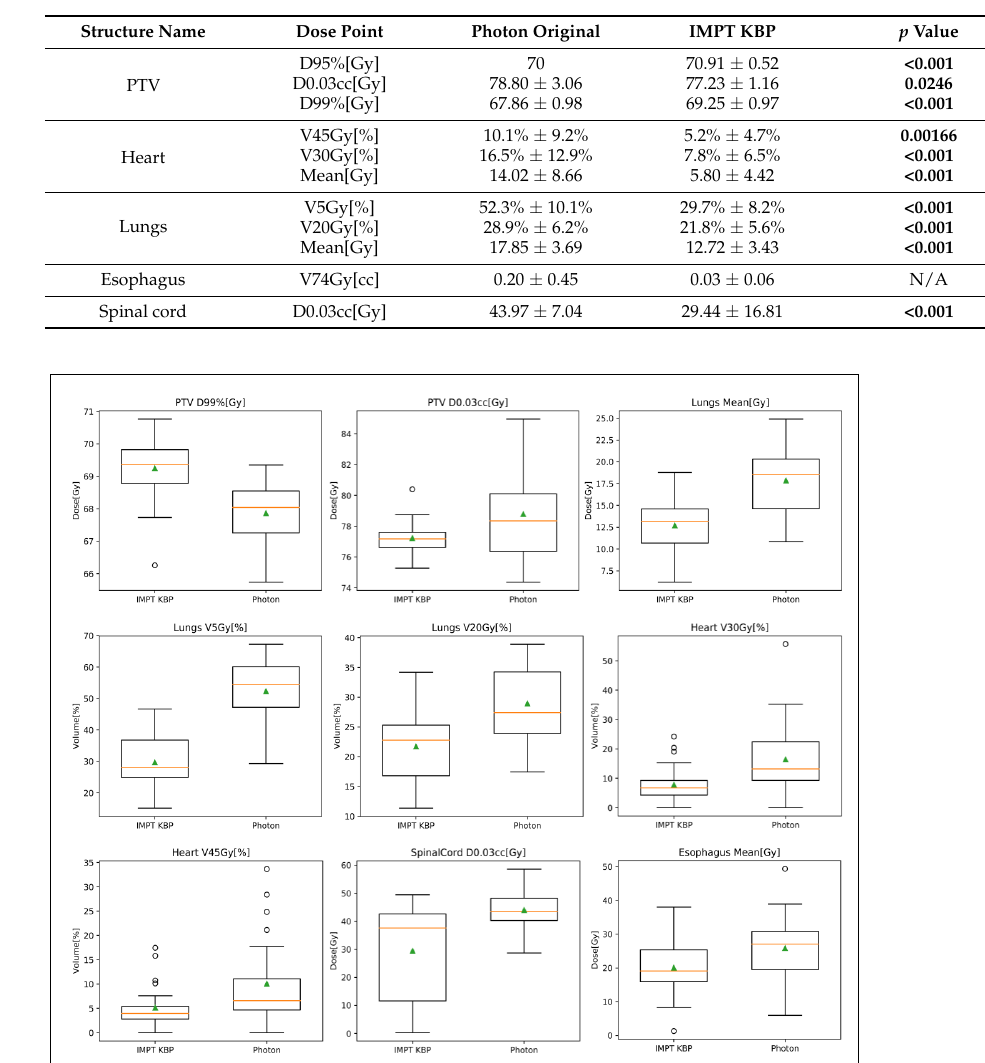
Table A1. Dose comparison and t -test results of forty submitted IMRT versus KBP IMPT plans.